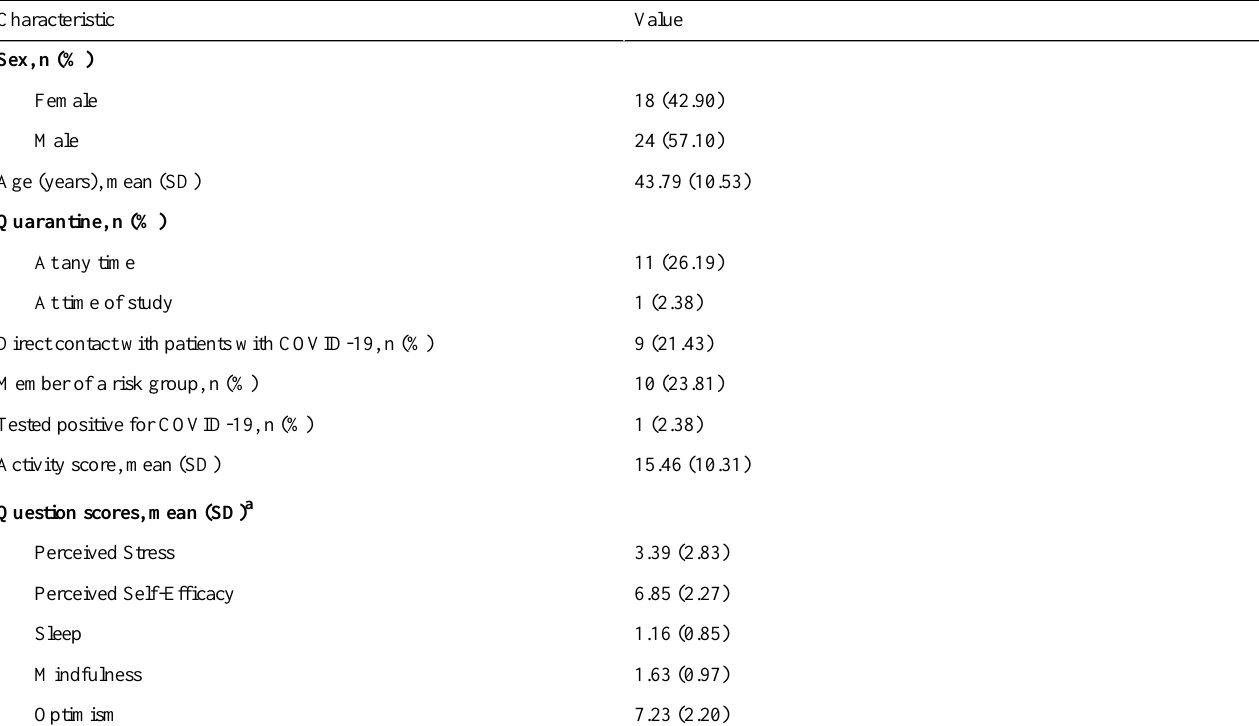
Table 1. Descriptive statistics